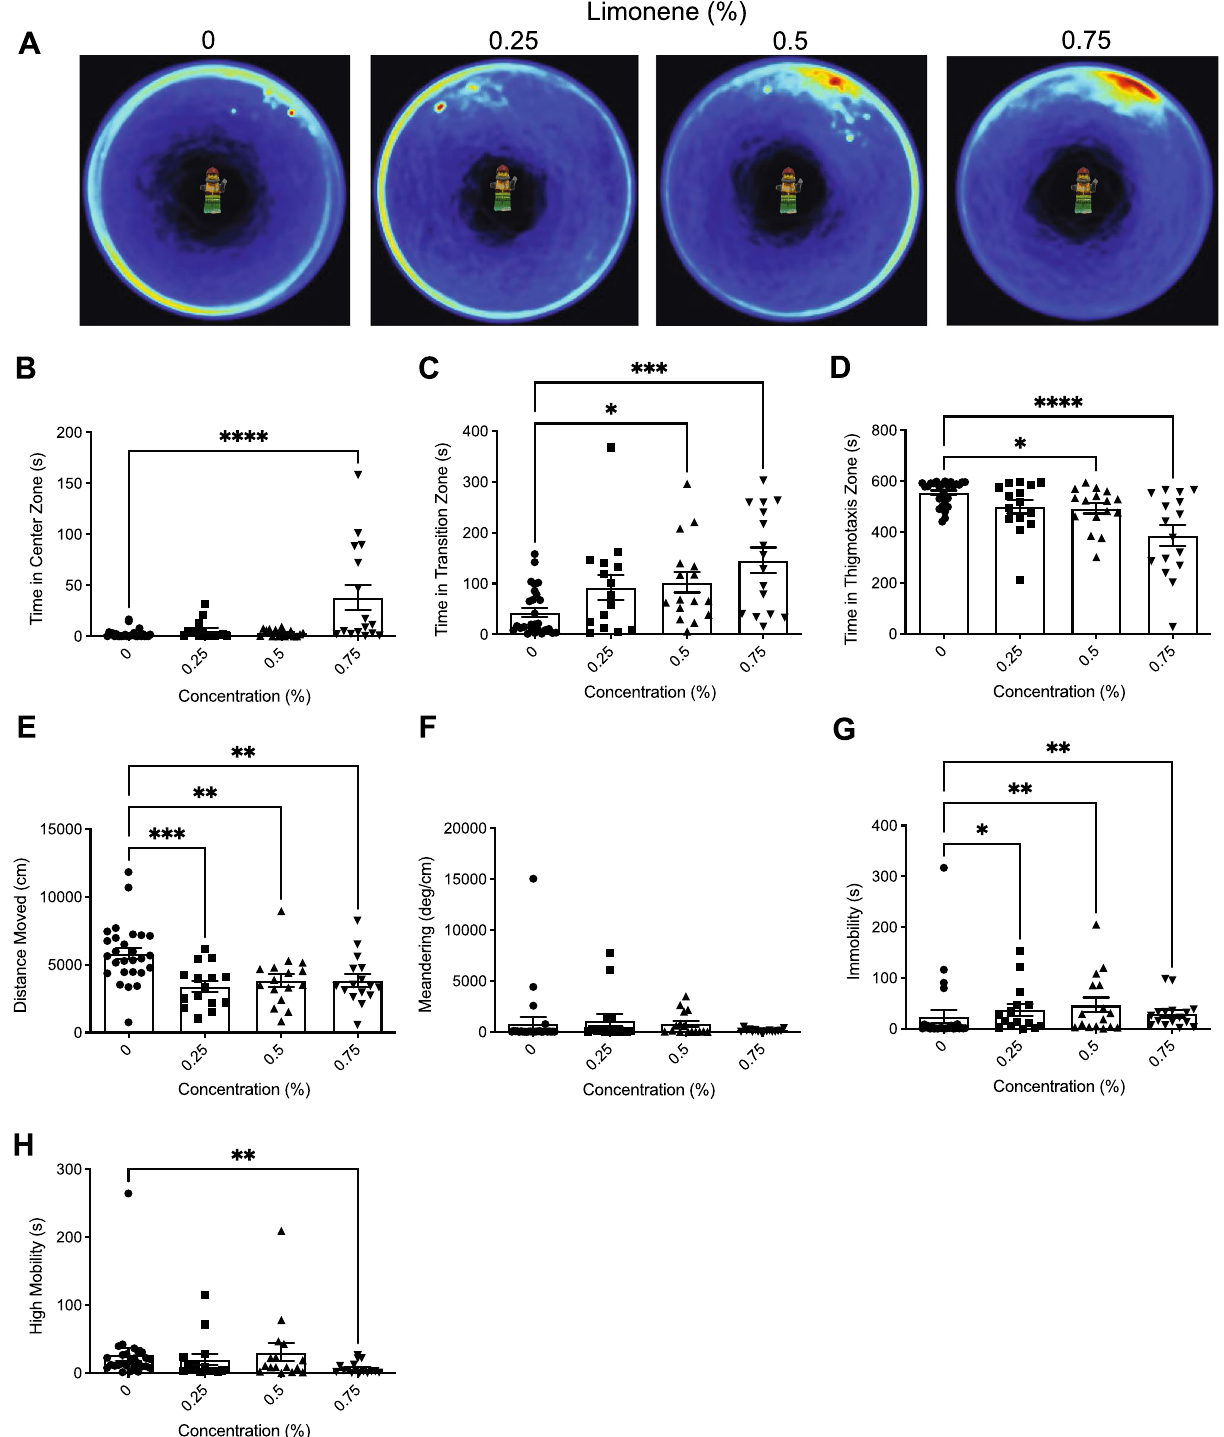
Figure 4. The effects of acute limonene administration on zebrafish behaviour assessed by the novel object approach test. ( A ) Group heatmaps showing a coloured representation of the combined mean location of each group of fish across all trials. Average time spent in the center ( B ), transition ( C ), and thigmotaxis ( D ) zone during the novel object approach test. Fish locomotion was quantified in the open field test by measuring distance moved ( E ), meandering ( F ), time spent immobile ( G ), and time spent highly mobile ( H ). All data are presented as mean ± S.E.M. Significant differences between controls and limonene treated groups are indicated by * (P < 0.05), **( P < 0.01), *** ( P < 0.001), and ****( P <